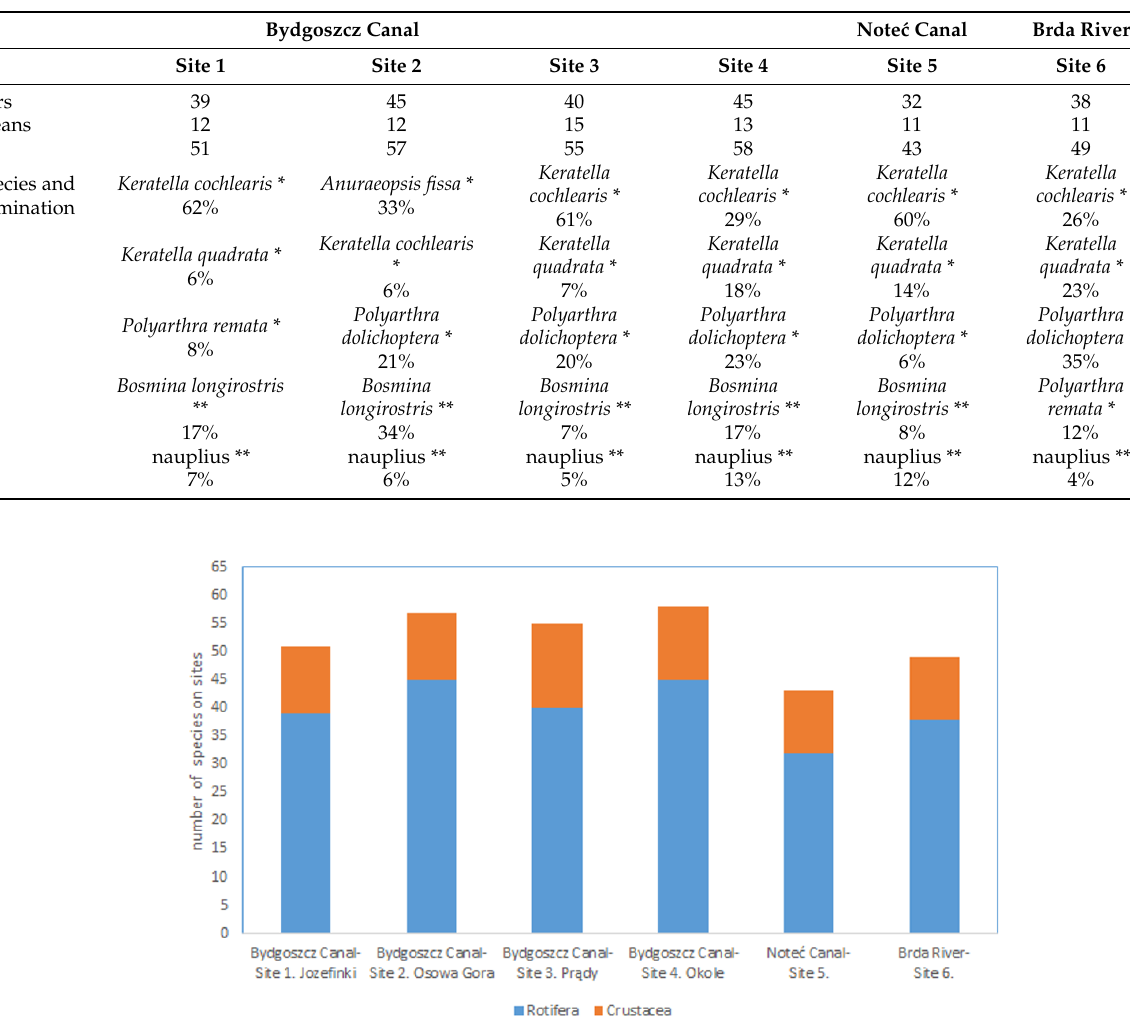
Figure 2. Number of zooplankton species during vegetation season in the Bydgoszcz Canal, the Noteć Canal , and the Brda River sites. Table 2. Total number of species (diversity) and dominants in the zooplankton community during growing season 2019 in the Bydgoszcz Canal, the Noteć Canal, and the Brda River sites (* Rotifer, ** Crustacean).